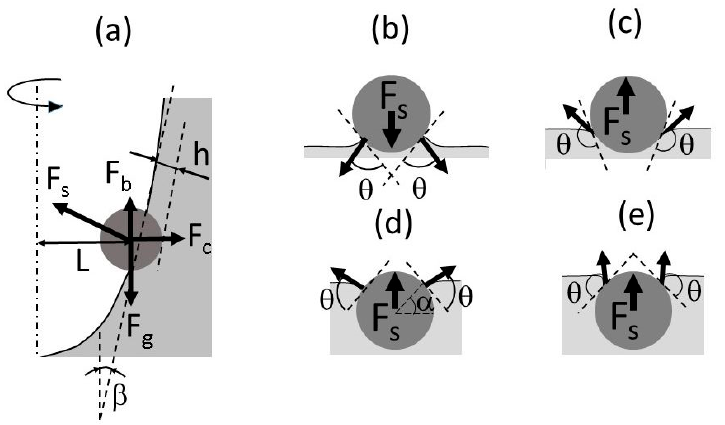
( c ) Figure 7. Predicted distribution of the mean square velocity in water near the vortex surface. ( a ) 250rpm, ( b ) 450rpm, ( c ) 650 rpm. 3. Discussion